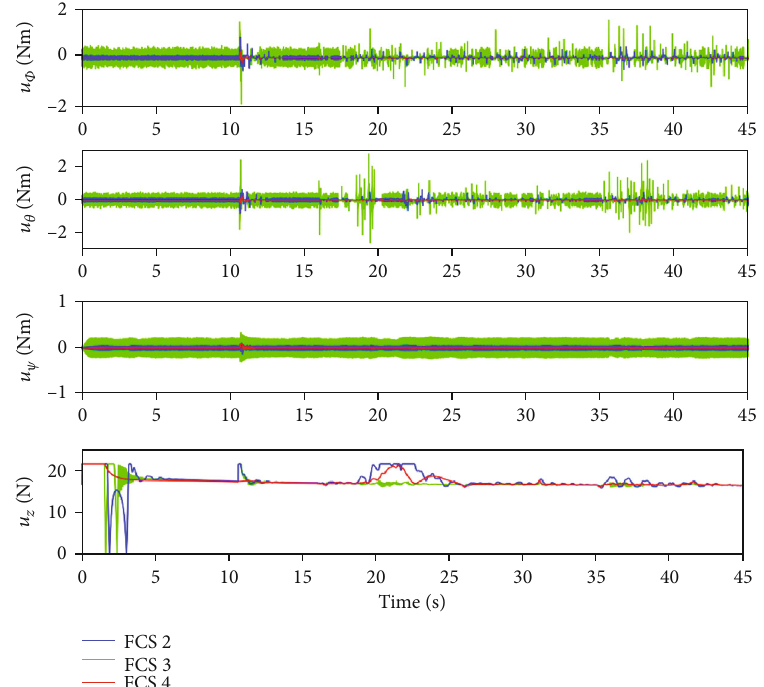
Þ by the FXESO observer: fl ight scenario , ̂ v , ̂ v x y z